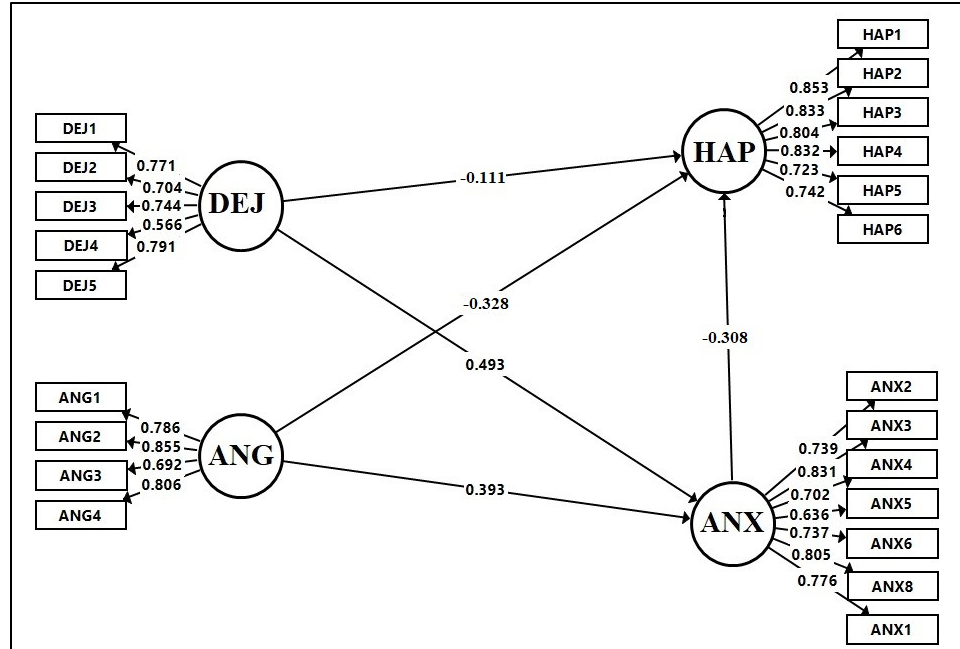
Figure 3. A completed structural model with exterior loading.